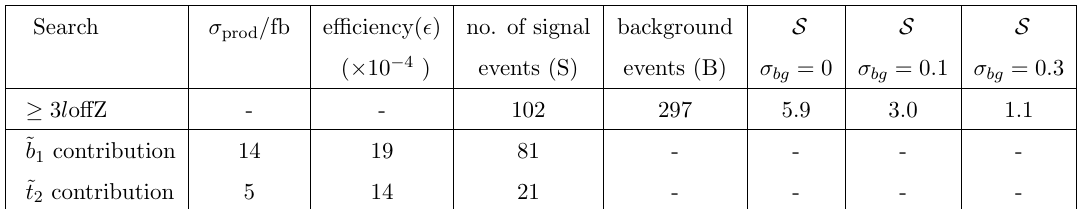
Table 3 . Multileptons search: e(cid:14)ciency of cuts, number of events, and signi(cid:12)cance of signal with 3000/fb of data at the 13 TeV LHC. We have de(cid:12)ned S (cid:17) S =